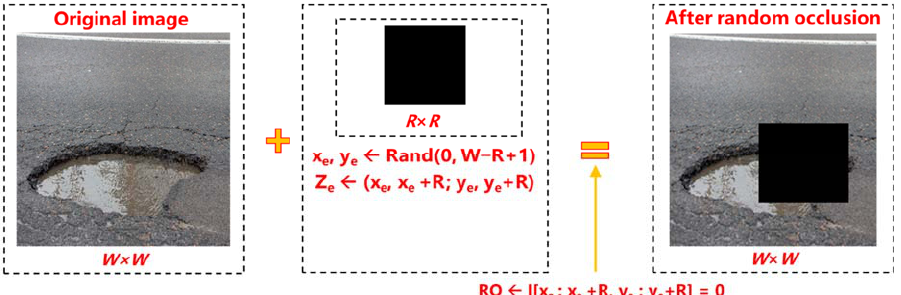
Figure 6. Generation of random occlusion.